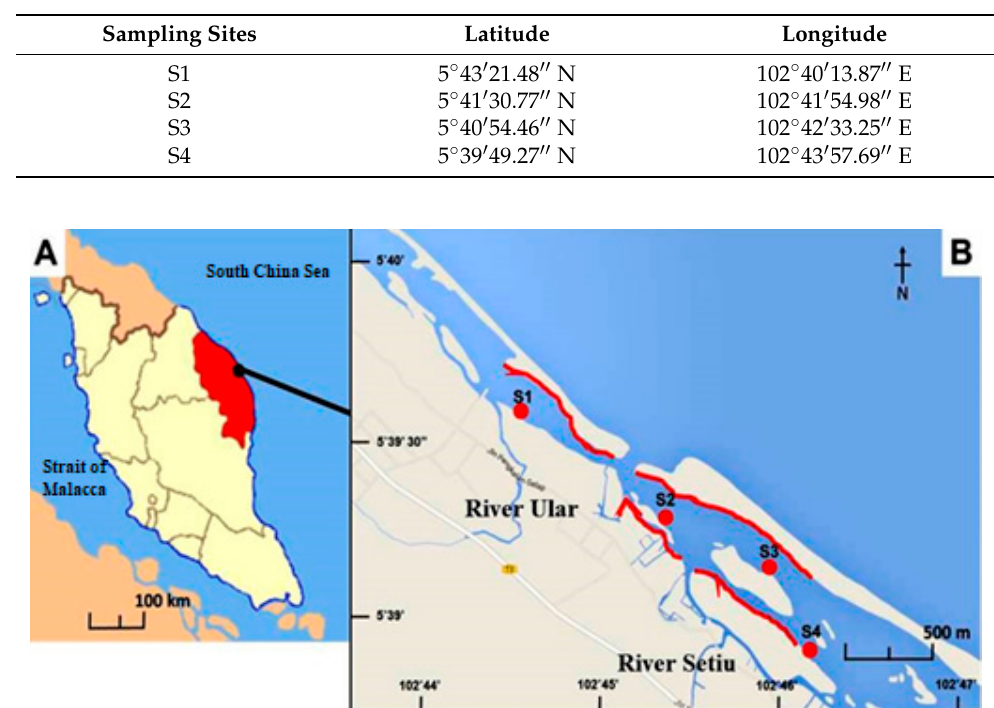
Figure 1. Map showing ( a ) Setiu Wetlands location at the east coast of peninsular Malaysia (facing South China Sea), and ( b ) Sampling stations S1–S4 at Setiu Wetland, Malaysia.